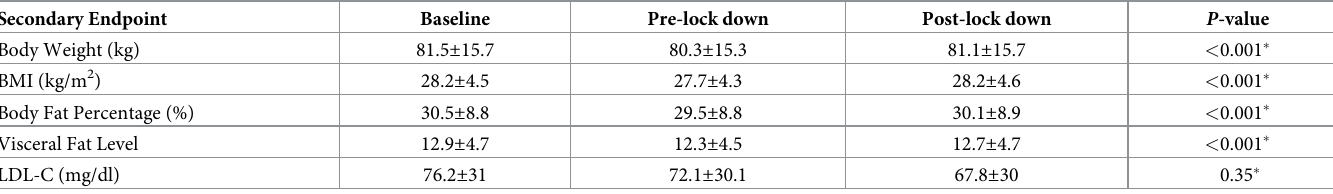
Table 2. Secondary endpoints at baseline, pre-lockdown, and post lock down measurements.